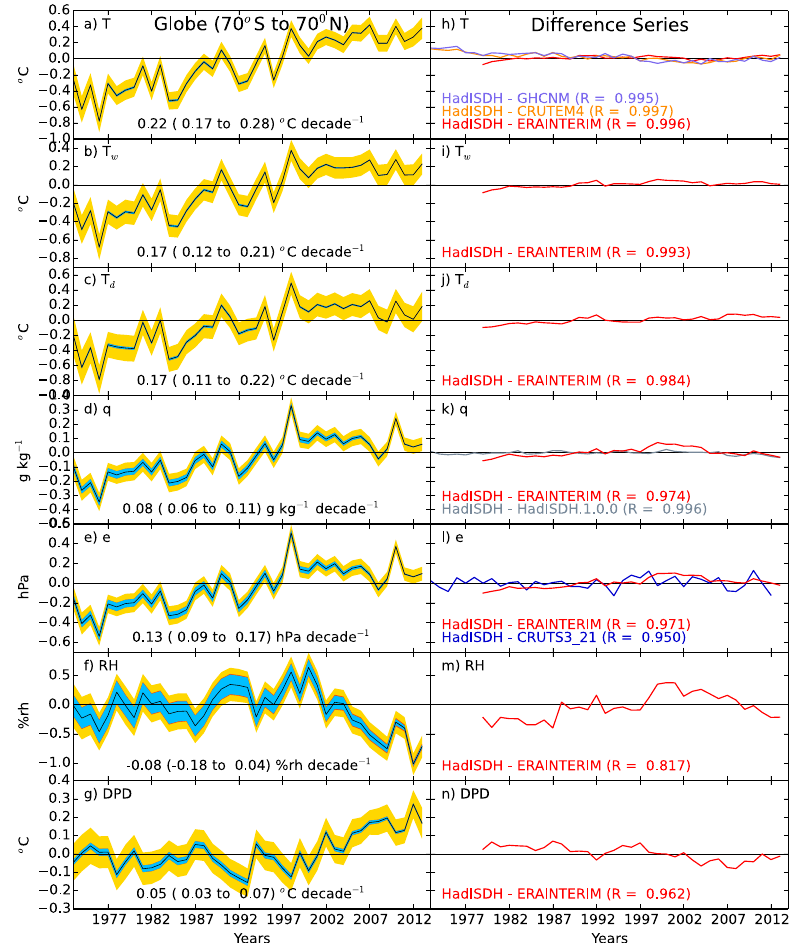
Figure 12. Comparison global (70 ◦ N to 70 ◦ S) average time series of annual mean climate anomalies from HadISDH.2.0.0 with difference series for other monitoring products spatially matched to HadISDH grid box size and coverage. HadISDH uncertainty ranges for station (blue), sampling (red) and coverage (gold) uncertainty contributions combined are shown. All series have been given a zero mean over the common 1981–2010 period. Decadal trends with 5th to 95th percentile confidence ranges are shown for HadISDH and correlation coefficients of the standardised climate anomalies (not detrended) are shown. (a, h) Temperature, (b, i) wet bulb temperature, (c, j) dew point temperature, (d, k) specific humidity, (e, l) vapour pressure, (f, m) relative humidity, (g, n) dew point